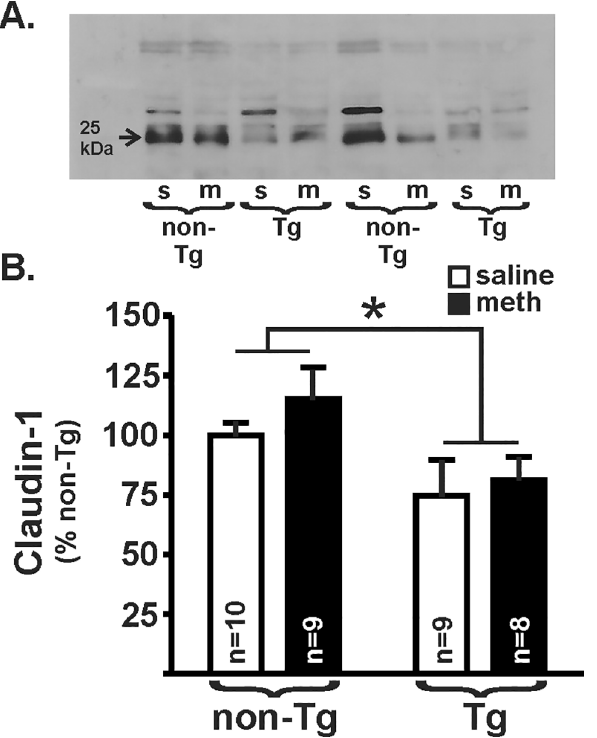
Fig 3. Claudin-1 protein expression. (A) I mmunoblot illustrating claudin-1 (23kDa) in the distal colon from 8 different samples (s, saline; m, meth). Arrow indicates molecular weight at 25kDa. (B) Overall, Tg rats had a significantly less claudin-1 compared to non-Tg rats ( p = 0.01). Methamphetamine (meth) self-administration did not result in a significant difference ( p = 0.34), and there was no interaction between genotype and meth ( p = 0.70). Horizontal lines indicate an overall effect of genotype from the two-way ANOVA ( (cid:3) p < 0.05).